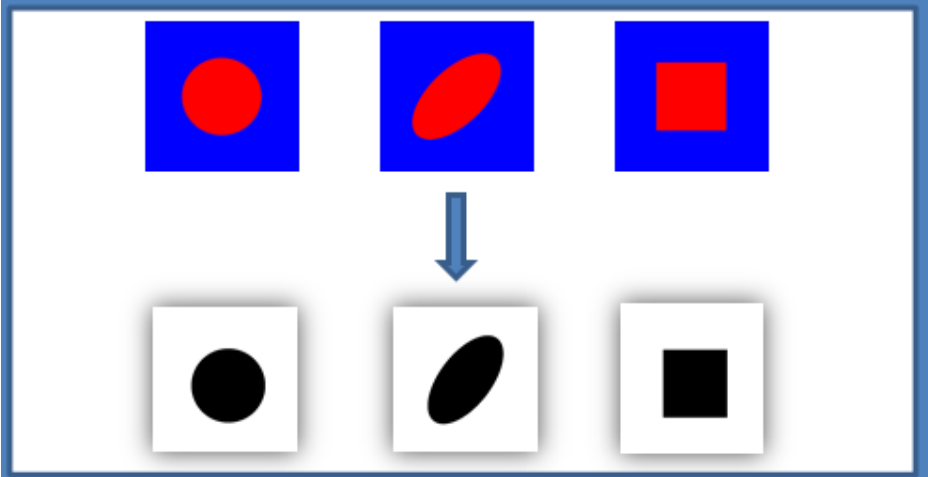
Figure 2. Binarization of the different microstructure images with a different shape and a fixed volume fraction (30%) using THRESH_BINARY function of OpenCV